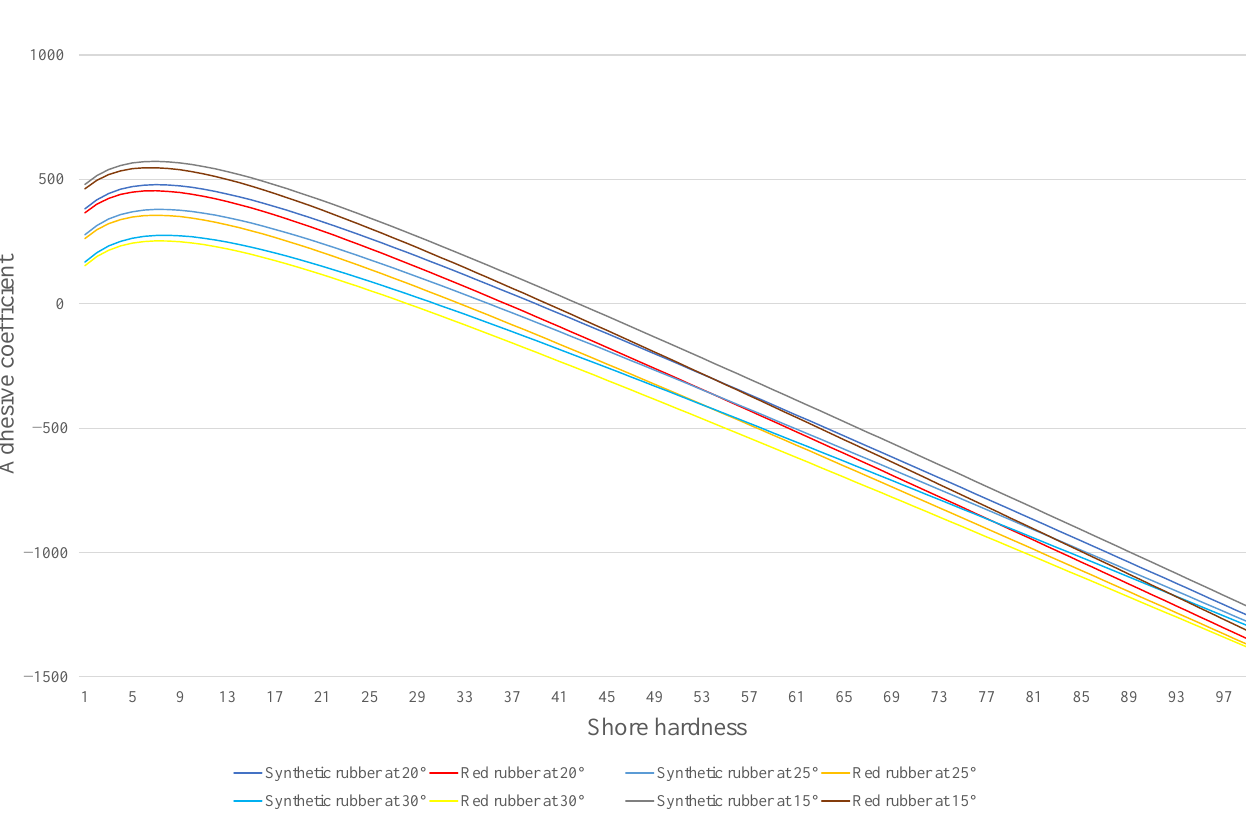
Figure 8. Relationship between adhesive coefficient and shore hardness. Table 3. Maximum value of shore hardness for each case of material and tilted angle. Material Tilted Angle Maximum Shore